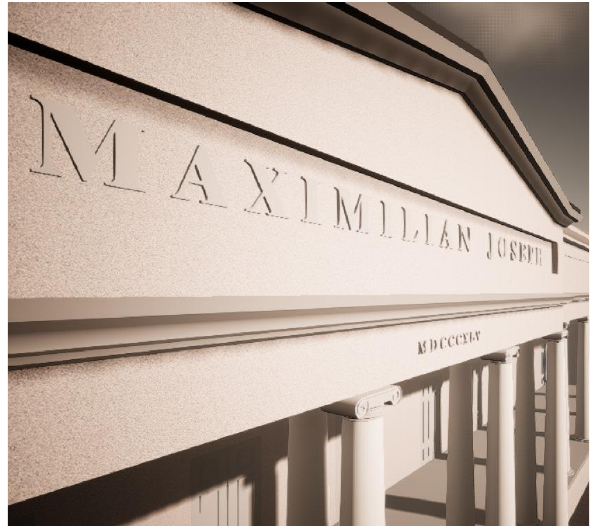
Figure 4 . Example - text on the